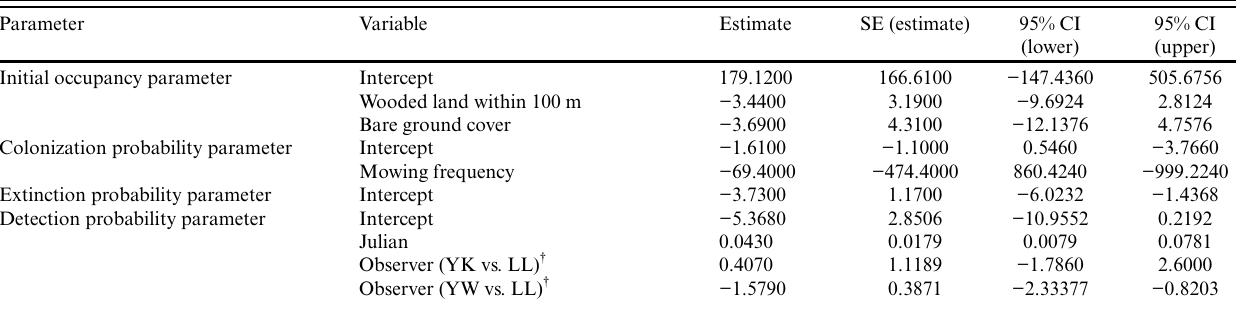
Table 3. Highest ranking multiseason occupancy model for Savannah Sparrow along 47 transmission line study sites in Winnipeg, Manitoba, Canada in 2008–2009. AICc = 250.89, Δ AICc = 0.00, AIC weight = 0.84, N = 276 surveys. Total Mackenzie-Bailey chi- square = 24.08 ( P = 0.02), Season 1 = 5.18 ( P = 0.35), Season 2 = 18.89 ( P = 0.02), c-hat = 2.47. Relative ranks of other models are provided in Appendix 4.